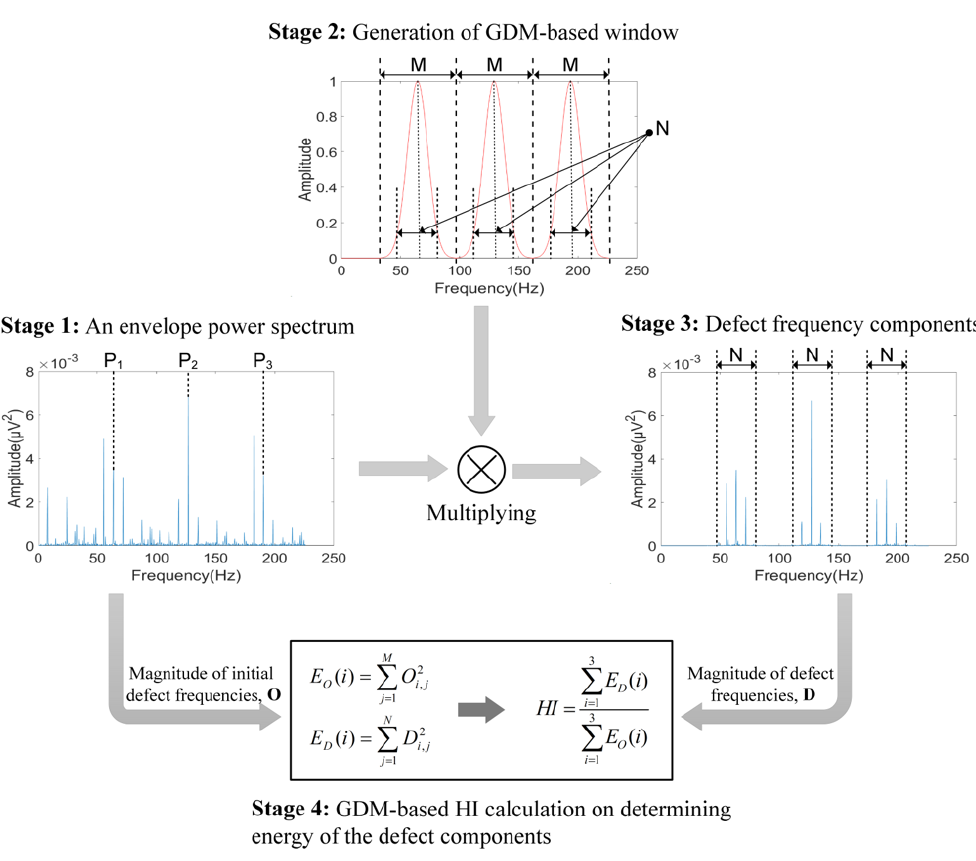
Figure 4. A description of the GDM-based HI calculation stages for each sub-band.